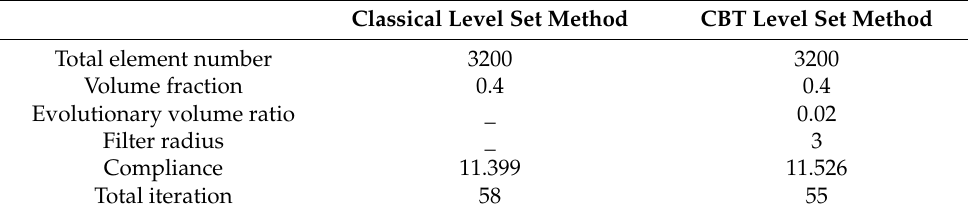
Table 3. Results for topology optimization of simple bridge beam.